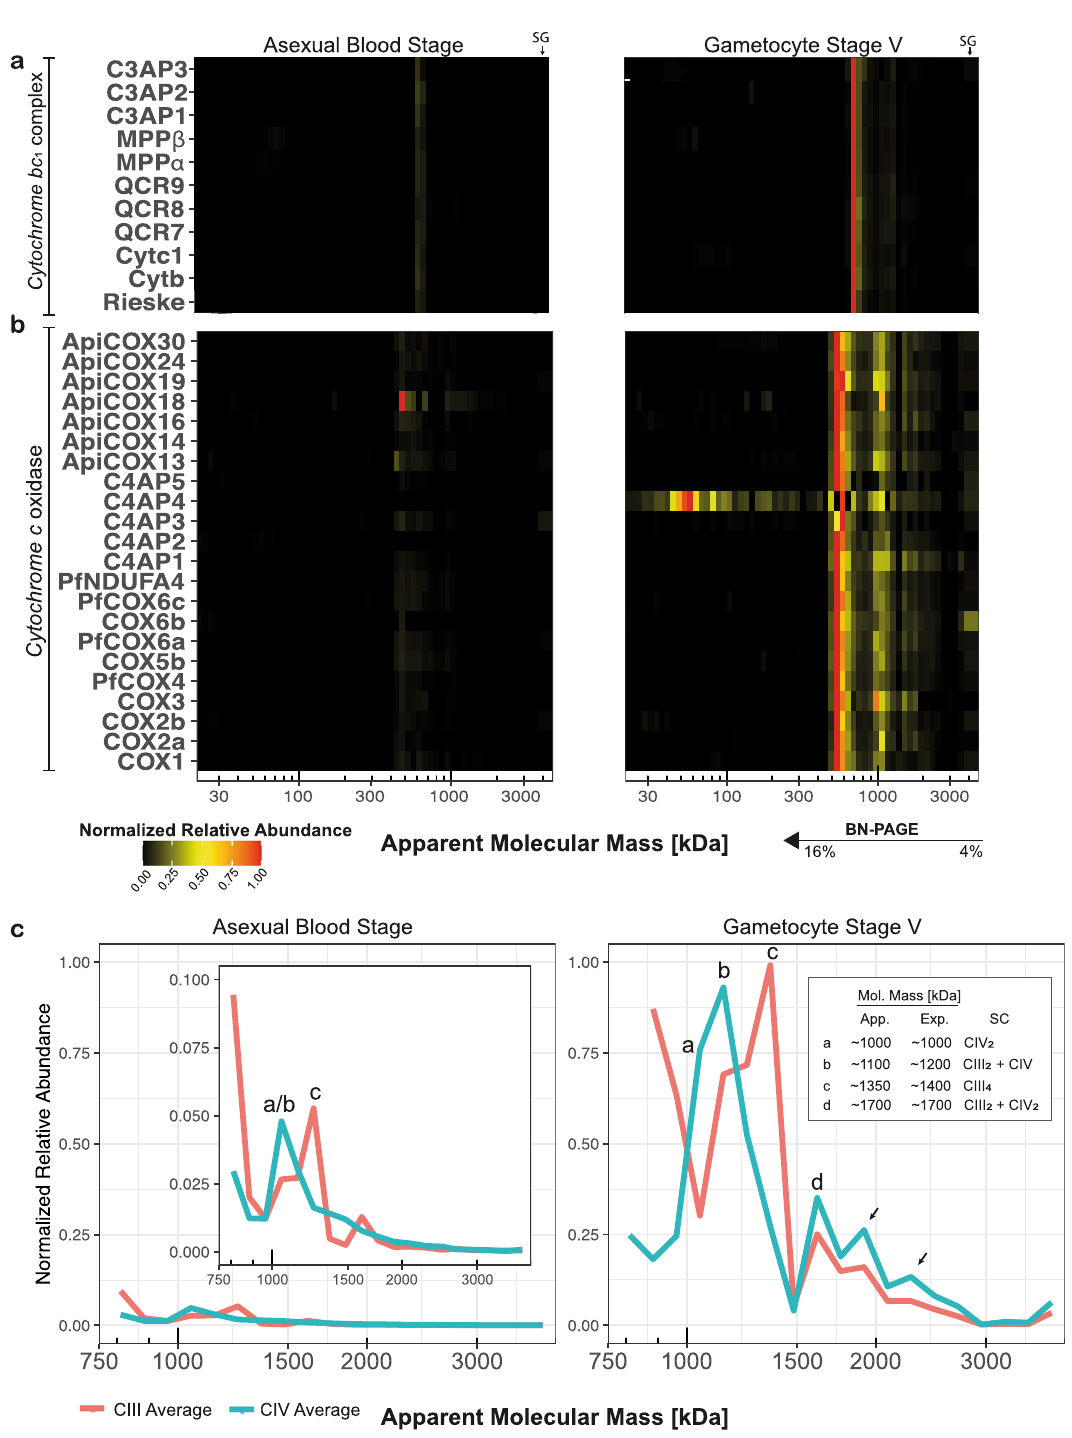
Fig. 3 Migration and relative abundance of canonical and putatively associated components of respiratory chain complexes III and IV. An abundance of 1 (red) represents the highest iBAQ value for a given protein between both samples. a Heatmap showing comigration of canonical CIII components as well as putative novel components migrating at an M r app. of ~730 kDa in ABS parasites (left) and gametocytes (right) respectively. b Heatmap showing comigration of canonical CIV components as well as putative novel components migrating at an M r app. of ~570 kDa as well as relative abundance in ABS parasites (left) and gametocytes (right). c For detailed analysis of higher-order assemblies, intensity values at M r app. >750 kDa were renormalized and visualized in a lineplot. Different putative supercomplexes were observed in ABS parasites and gametocytes, denoted with lettering and described in the graph inlet. App. approximate molecular mass based on migration pro fi le, Exp. expected molecular mass based on composition observed in this study, SC supercomplex, CIII 2 obligatory CIII dimer, CIII 4 association of two CIII dimers, CIV CIV monomer, CIV 2 CIV